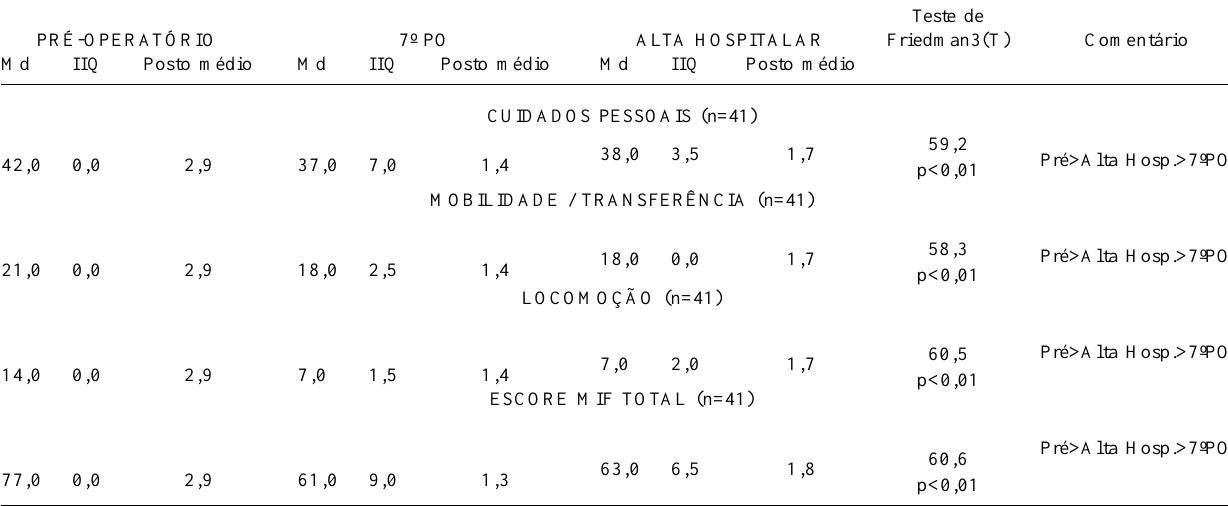
Tabela 3. Medidas de posição, dispersão, resultados dos testes e comentário, entre os momentos Pré, 7º dia pós-operatório (7º PO) e Alta hospitalar, segundo as categorias Cuidados Pessoais, Mobilidade/Transferência, Locomoção e escore MIF total.